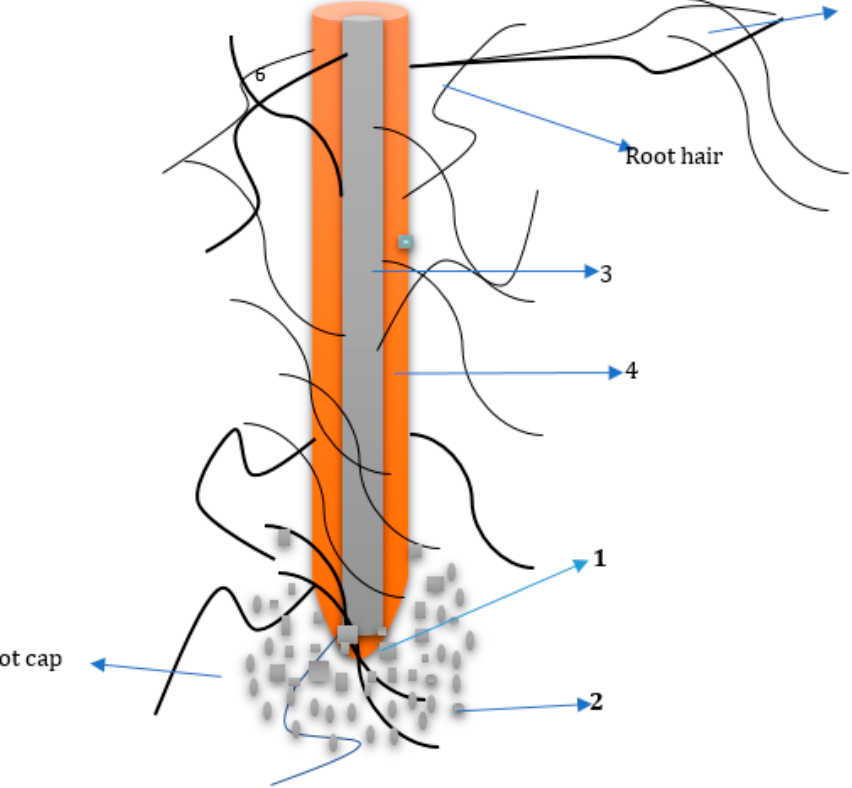
Figure 1. A typical diagram of a plant root representing the six main zones of rhizodeposits. (1) Lysis of lid and marginal cells, (2) lysis of complex and impenetrable mucilage, (3) lysis of simple and penetrable root exudates, (4) lysis of volatile organic compounds, (5) lysis of carbon to mutualists and (6) lysis of carbon due to root epidermal and cortical cell death.